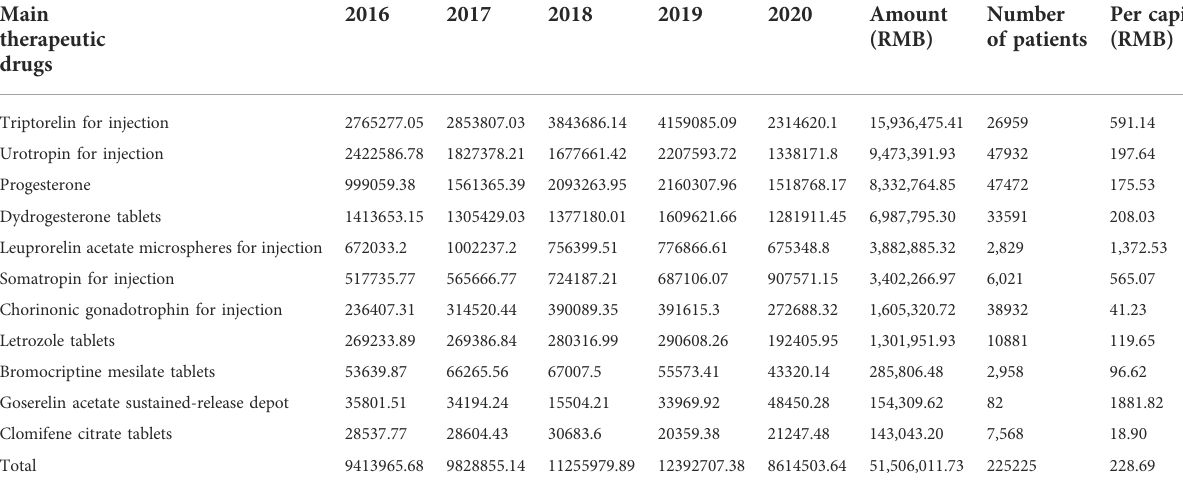
TABLE 3 Cost of therapeutic drugs use per person each year from 2016 to